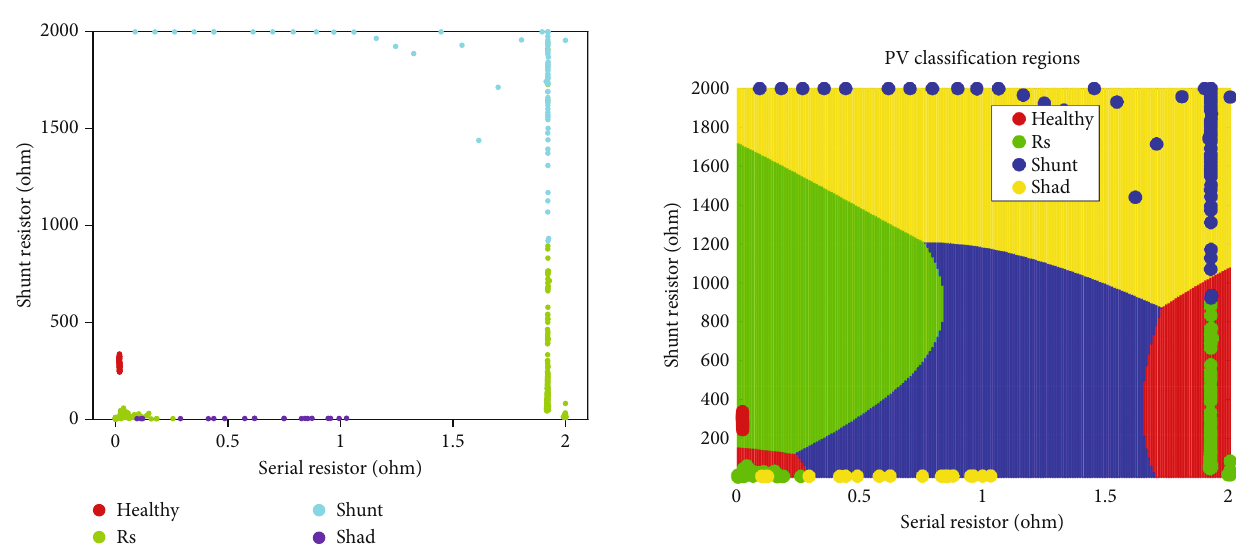
Figure 13: Defect classi fi cation by